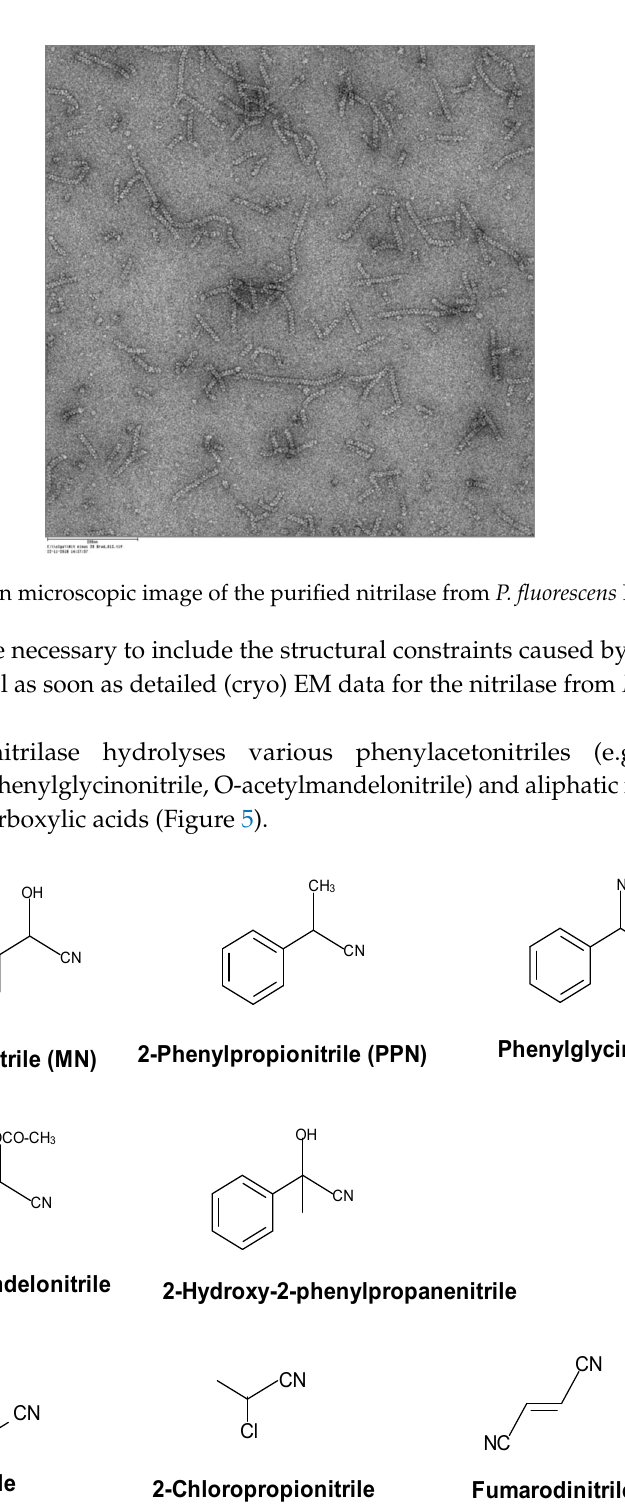
Figure 5. Examples for nitriles which are converted by the nitrilase from Pseudomonas fluorescens EBC191.